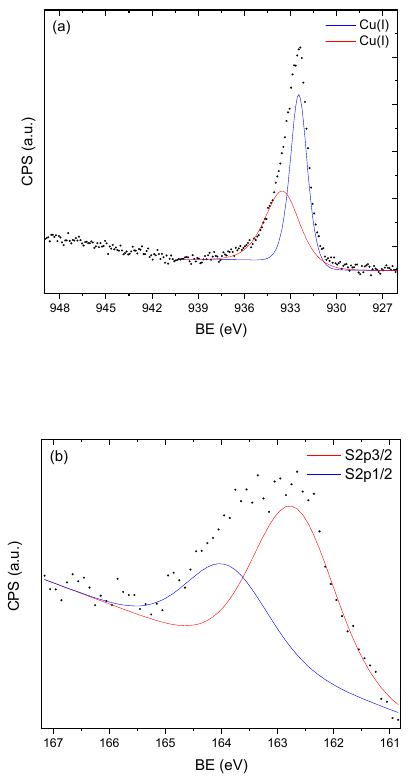
Figure 3. The ( a ) copper 2p 3 / 2 and ( b ) sulfur 2p 3 / 2,1 / 2 X-ray photoelectron spectra of the silica sample after H 2 S adsorption. CPS: Counts per second, BE: Binding Energy.